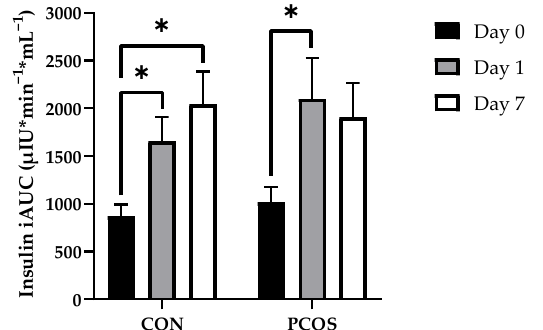
Figure 5. Insulin iAUC mean values ( ± SE) in CON ( n = 15) and PCOS ( n = 14). * = significance between days, p < 0.05. CON = non-PCOS women; iAUC = incremental area under the curve; PCOS = women with polycystic ovarian